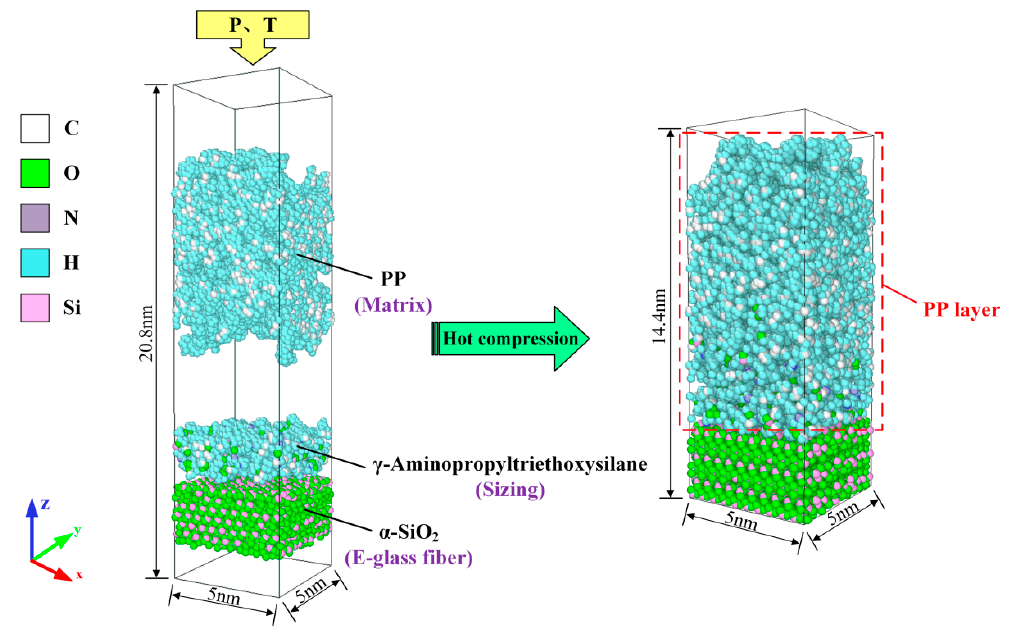
Figure 3. Molecular dynamics (MD) visualization of glass fiber–PP interface model.